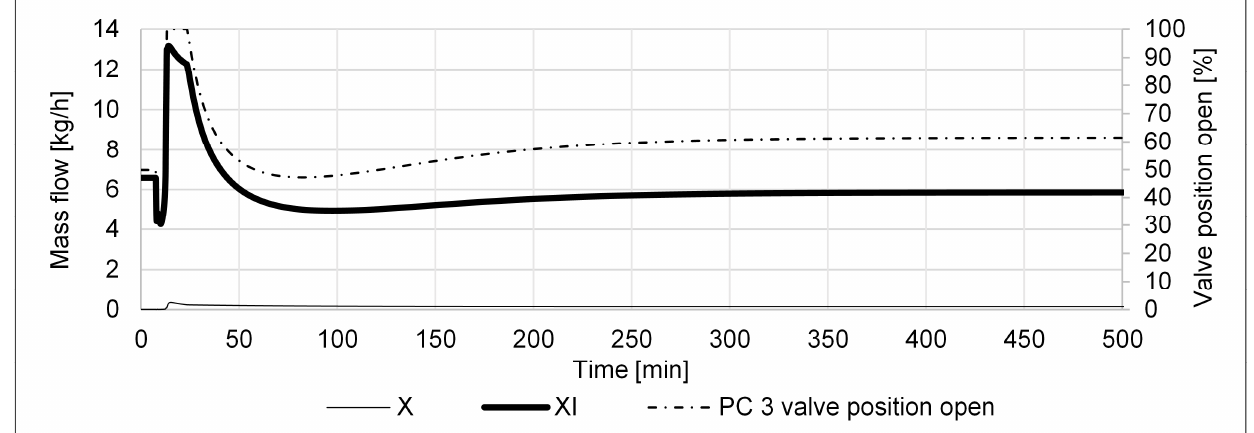
Figure 30. Purge X and recycle XI mass flows and position of the recycle valve (left and right vertical axis) of scenario (j).